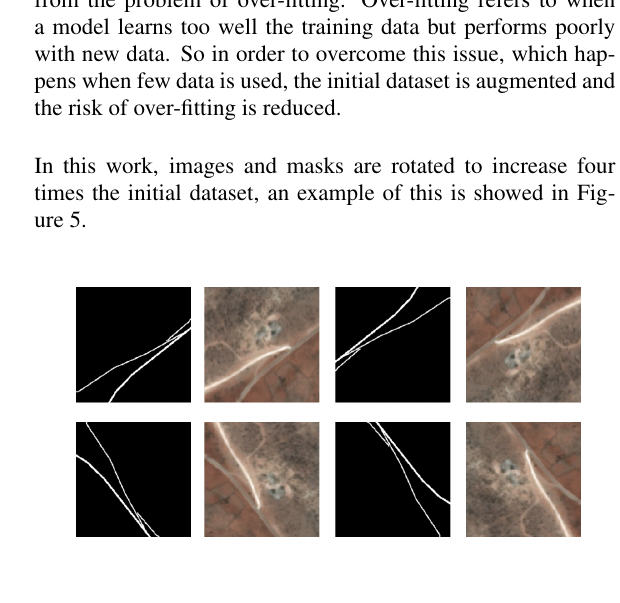
Figure 5. Sample of image augmentation by